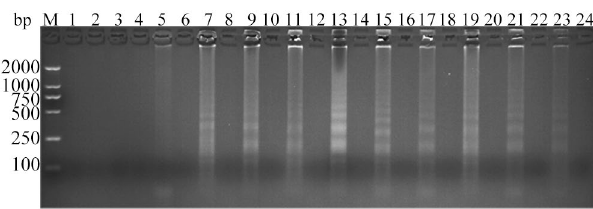
Figure 7. Analysis of ALV-J CPA at different temperatures by agarose gel electrophoresis. Lane M, DNA marker; 1, 54 °C; 3, 55 °C; 5, 56 °C; 7, 57 °C; 9, 58 °C; 11, 59 °C; 13, 60 °C; 15, 61 °C; 17, 62 °C; 19, 63 °C; 21, 64 °C; 23, 65 °C; 2, 4, 6, 8, 10, 12, 14, 16, 18, 20, 22 and 24 were negative controls for the corresponding temperatures. The full-length gel is presented in Supplementary Figure